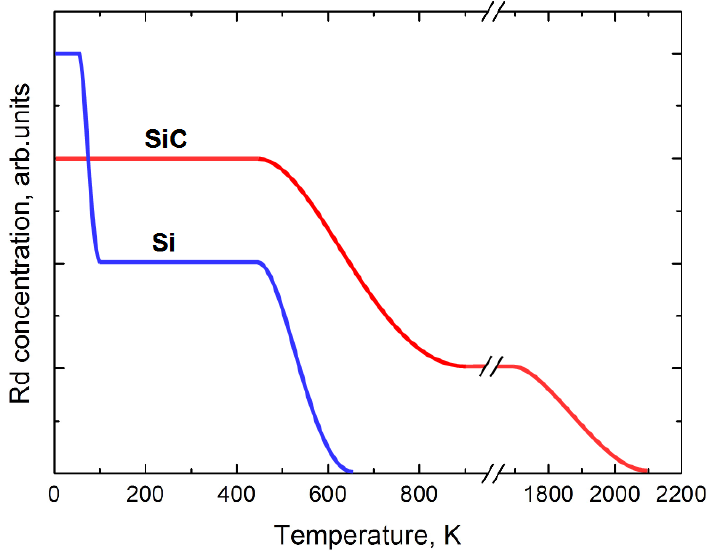
Figure 9. Schematic comparison of how the radiation defects are annealed-out in SiC and Si